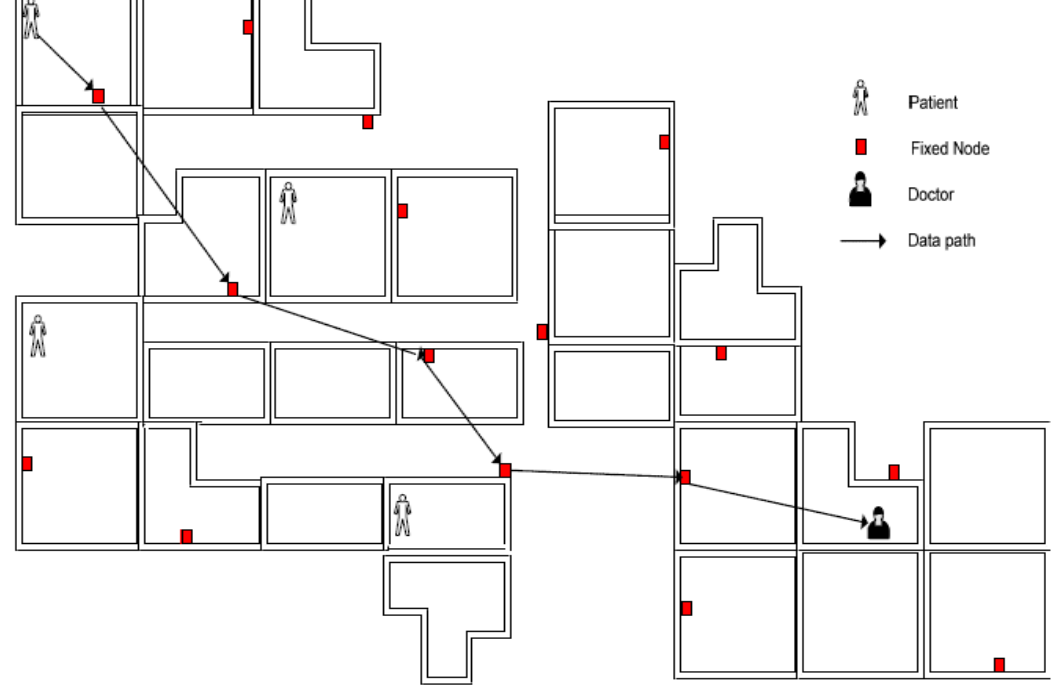
Figure 1. A dynamic WSN scenario in hospital